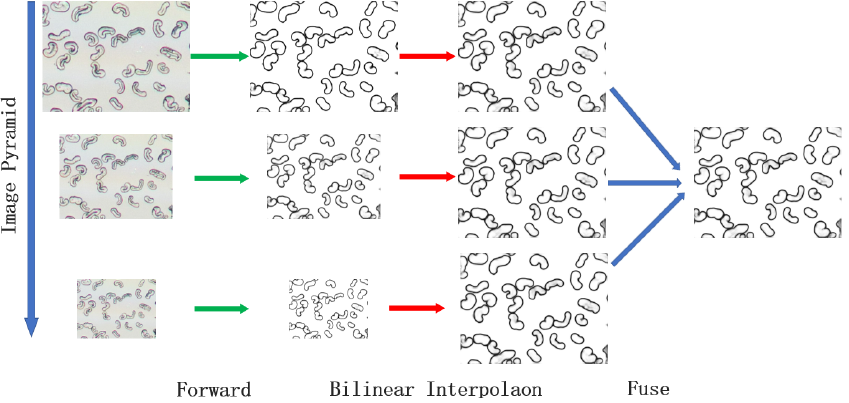
Figure 9. The schematic diagram of multi-scale edge detection and fusion of image